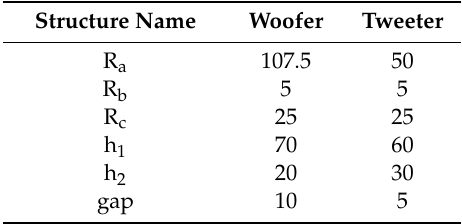
Figure 4. The f measurement positions according to the IEC TS 62764 standard.